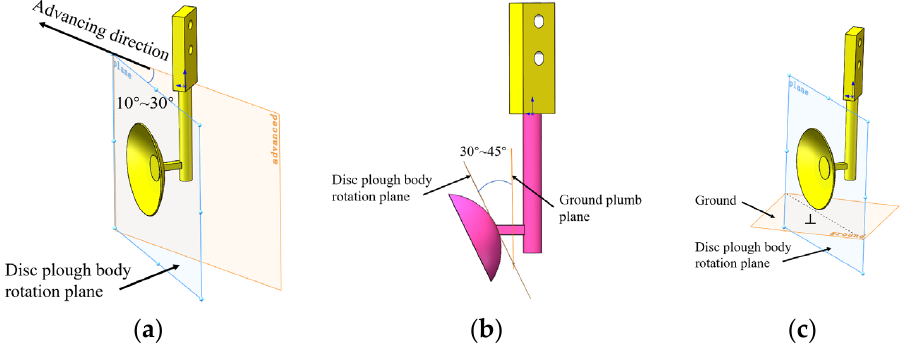
Figure 2. Installation angle of disc plow. ( a ) Disc plow installation angle; ( b ) ordinary type of disc plow; ( c ) vertical type of disc plow.